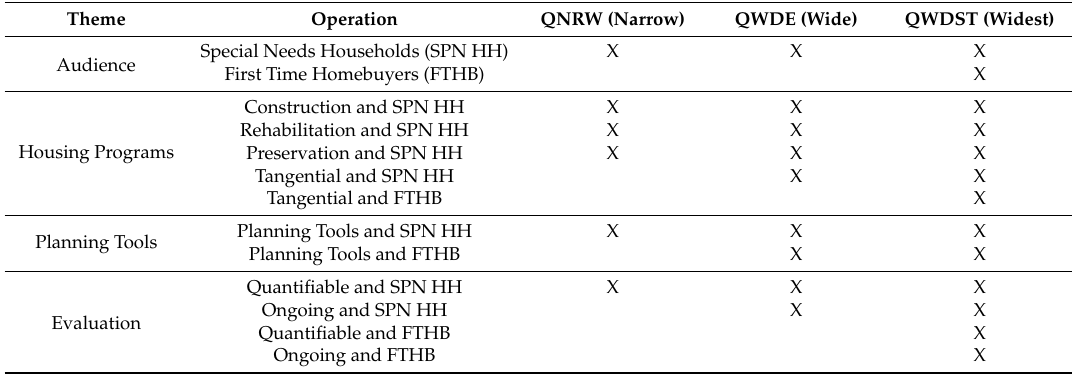
Table 1. Components of the Plan Quality Measures. Due to the non-mutually exclusive data, the theme items were configured to test three interpretations of California’s Housing Element